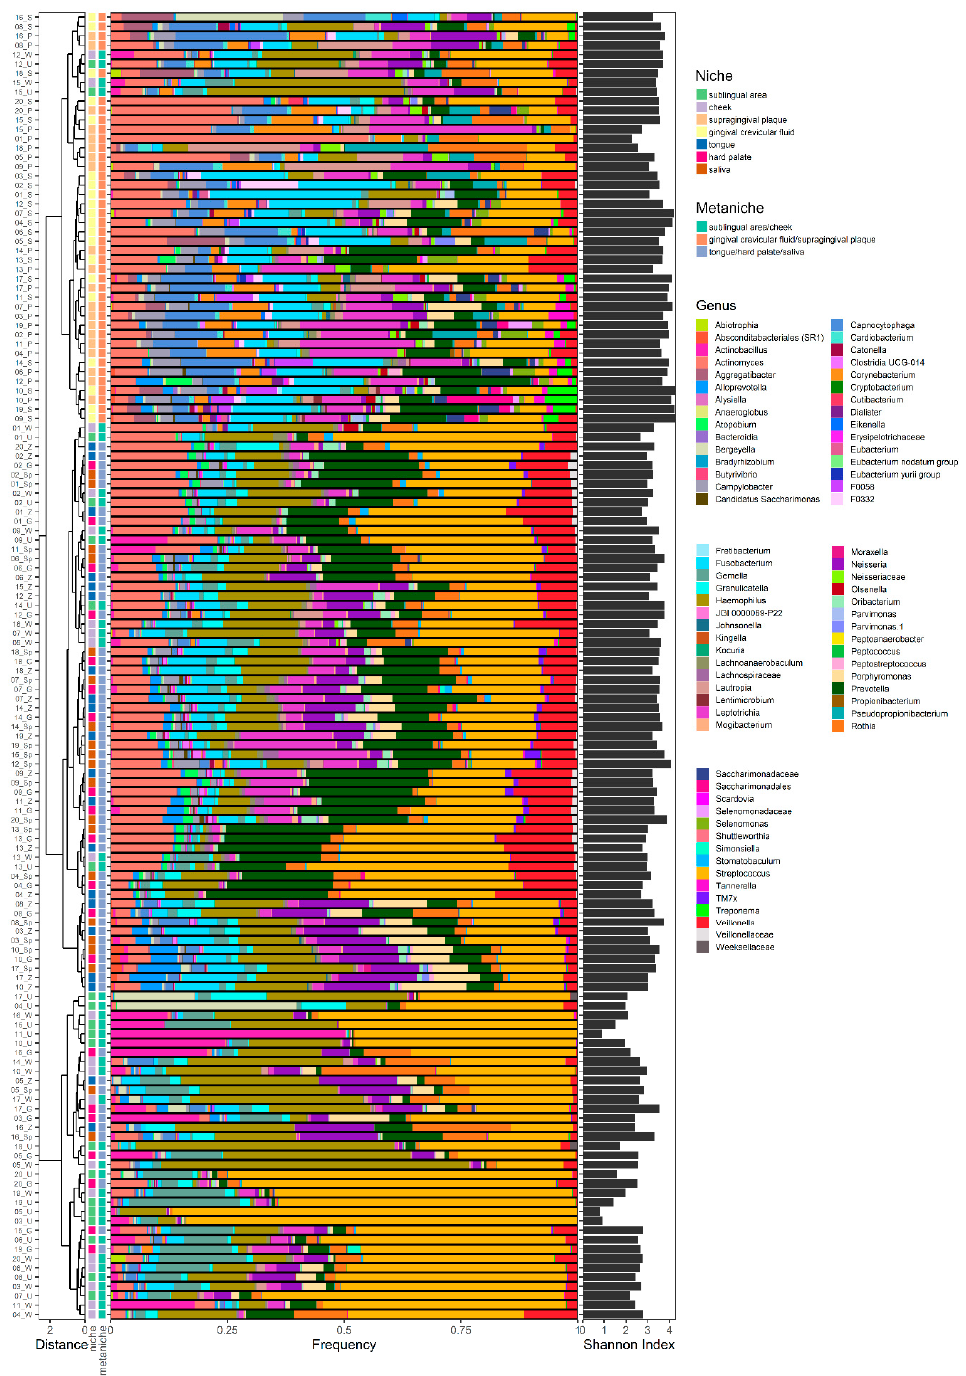
Figure 1. Dendrogram, genus frequencies plot, and Shannon index representing the genera detected in different oral niches and metaniches. A dendrogram based on generalized UniFrac distances is given for all oral niches (sublingual area, cheek, supragingival plaque, gingival crevicular fluid, tongue, hard palate, saliva) and metaniches (sublingual area/cheek; gingival crevicular fluid/supragingival plaque; tongue/hard palate/saliva) for each individual subject and sample (colour key is given on the right side). Genus frequencies found in the individual microbiotas are given with acolourkeyforthedi ff erentgenera, which are sorted alphabetically and presented horizontally from the left to the right side. The Shannon diversity index is given on the right